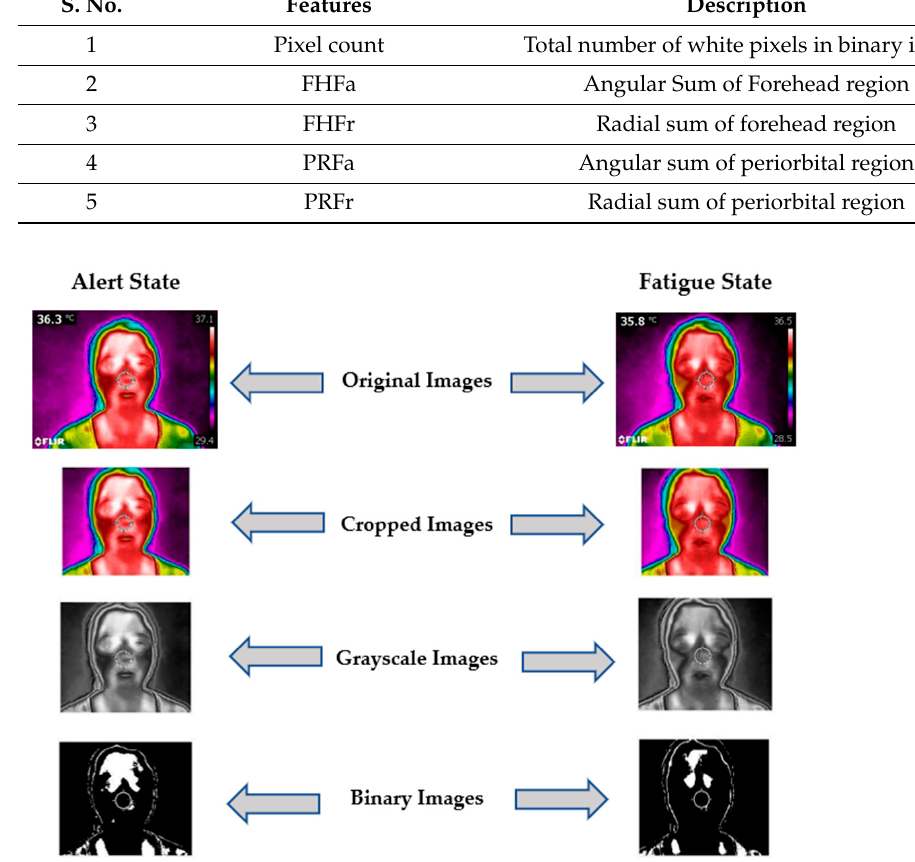
Figure 3. Depiction of thermal image processing. To extract the other four thermal features (two from the periorbital region and two from the forehead region), the ROIs from the thermal image have been selected, as shown in Figure 3. During experiments, it has been observed that the periorbital region and forehead region are significant RIOs. Thermal and visual spectrum images are captured by the same camera, i.e., Flir C2. The visible spectra image is resized to match the thermal image size, i.e., 320 × 240 pixels. Afterward, the eye pair region is extracted from the visual spectrum image using the Viola-Jones algorithm, and we get a bounded box over the eye pair. The coordinates of the bounded box to get the ROIs for the periorbital region from the thermal image. The exact size bounded box is put adjoining above this to obtain fore- head features. After ge tt ing ROIs, the next step is to obtain FPS (Fourier power spectrum) features from selected ROIs. This texture model provides texture features related to infor-